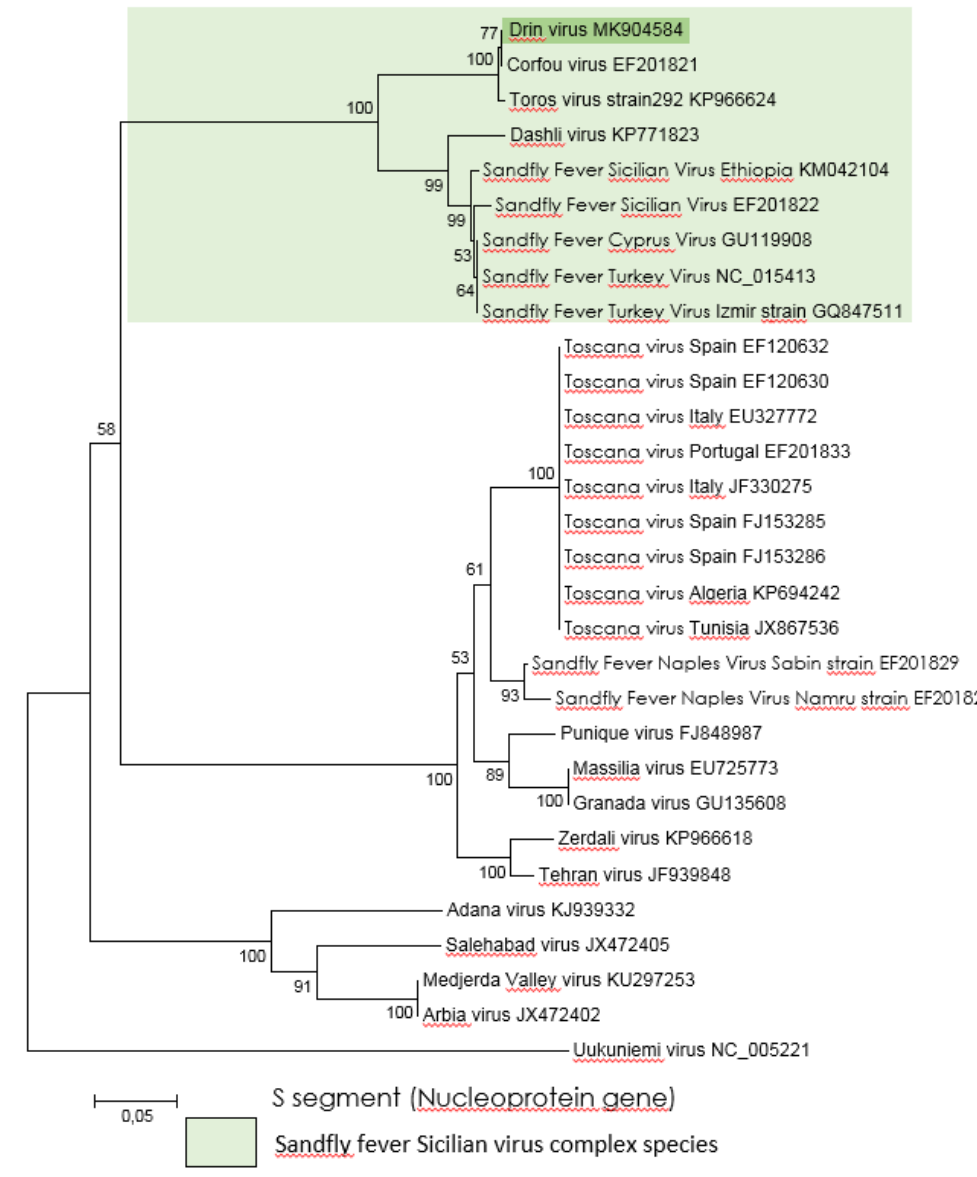
Figure 3. Phylogenetic analysis of the phlebovirus amino acid sequence. Neighbor-joining (NJ) phylogeny trees were generated using the Kimura 2-parameter model with 1000 bootstrap replication. ( A ) L protein amino acid sequence (167 AA). ( B ) Gc protein amino acid sequence (170 AA). ( C ) Nucleoprotein amino acid sequence (170 AA). GenBank accession numbers are inserted in the taxon’s nomination.